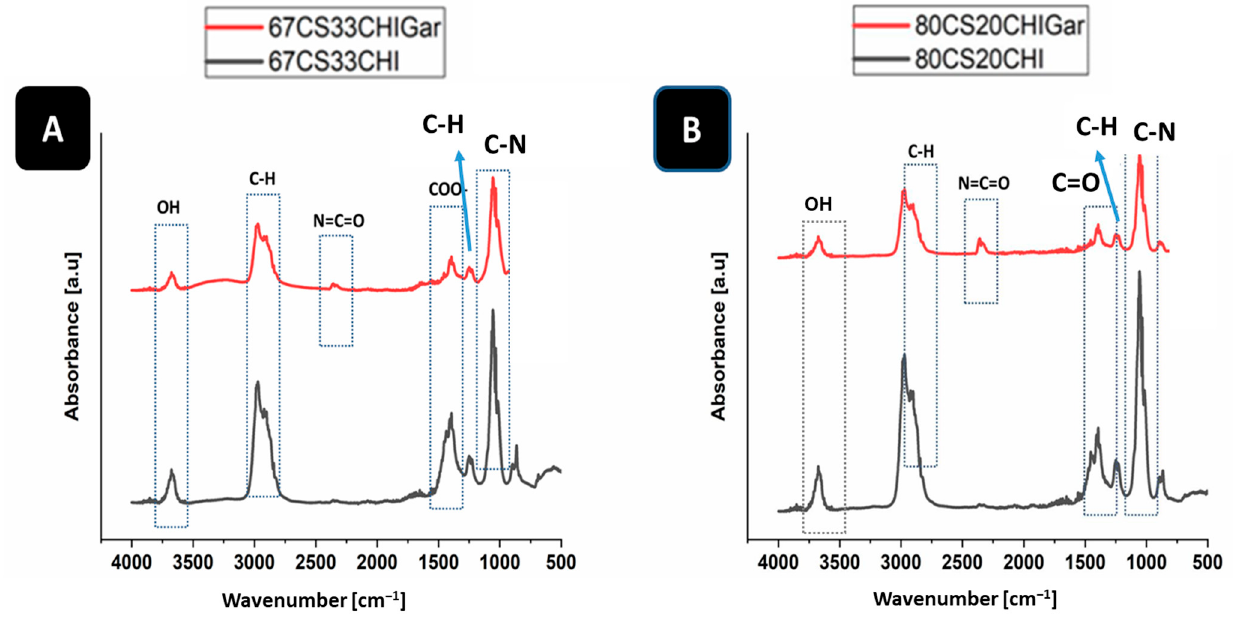
Figure 2. FTIR spectra of ( A ) 67CS33CHI, 67CS33CHIGar hydrogels and ( B ) 80CS20CHI, 80CS20CHIGar hydrogels.